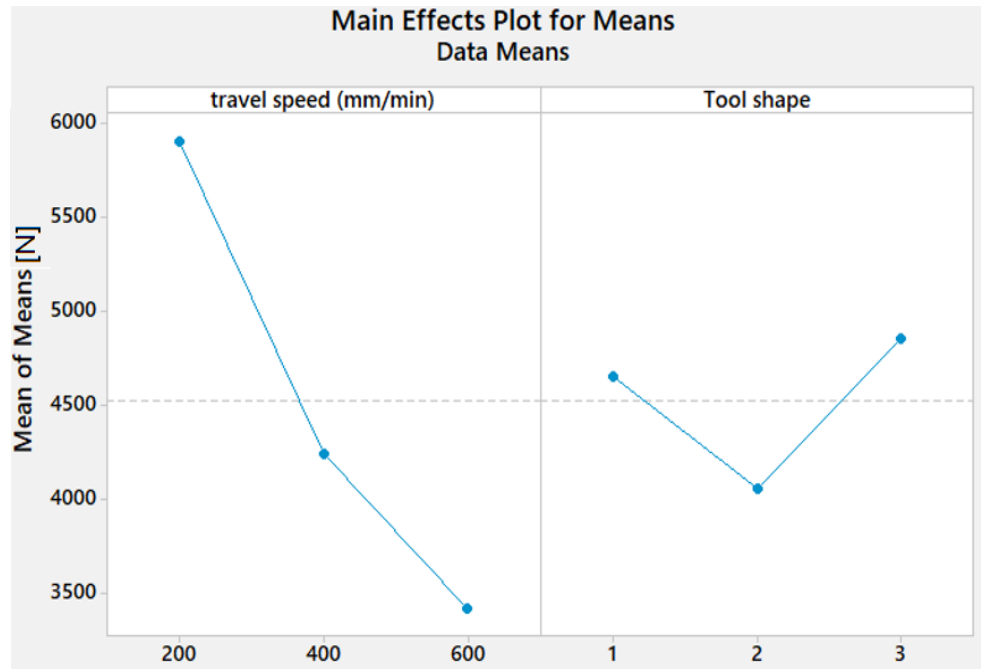
Figure 5. Effect of process parameters on the TSL of AA1050 thick lap joints.